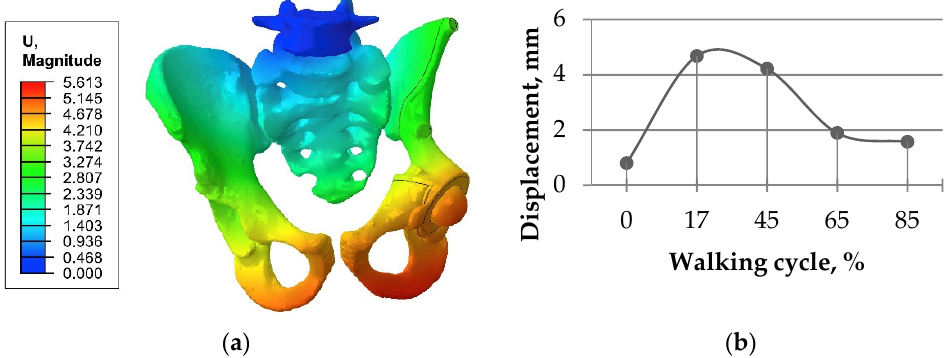
Figure 6. Total displacement in the “bone–endoprosthesis” system for the walking condition and a screw load of 1000 N: ( a ) typical displacement distribution (mm); ( b ) displacement values for the full gait cycle at the spherical center of the left femoral head.